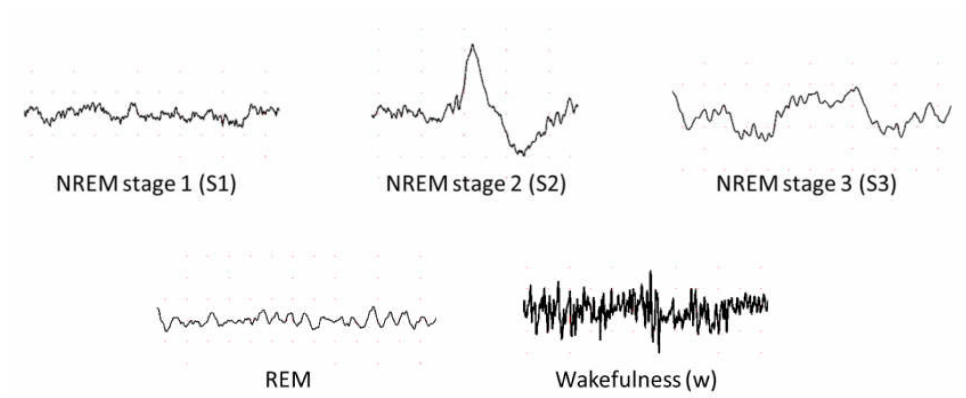
Figure 5. Examples of electroencephalography (EEG) signals in di ff erent sleep stages.